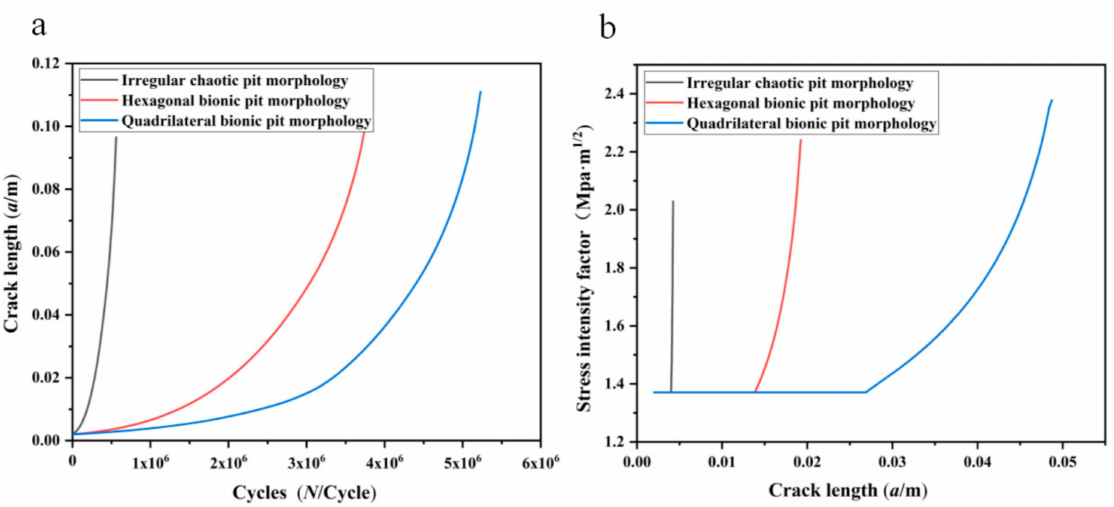
Figure 15. Comparison of fatigue crack growth characteristic parameters of different bionic pit morphology models: ( a ) fatigue crack growth a – N curve of different bionic morphology models; ( b ) relationship curve between stress intensity factor and crack